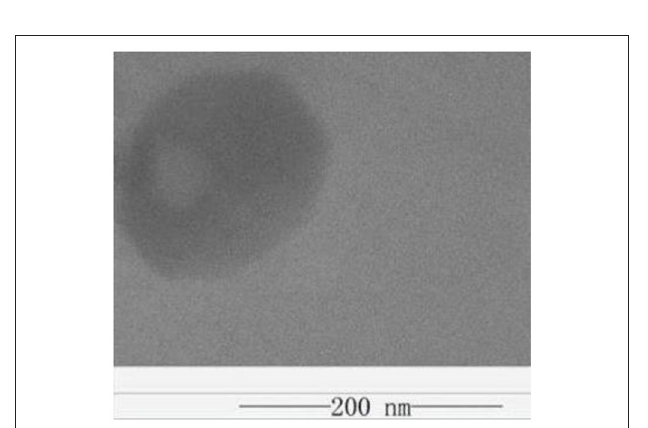
FIGURE 7 | TEM of PLA combined Fe 3 O 4 -GO-ASA nanobubbles.